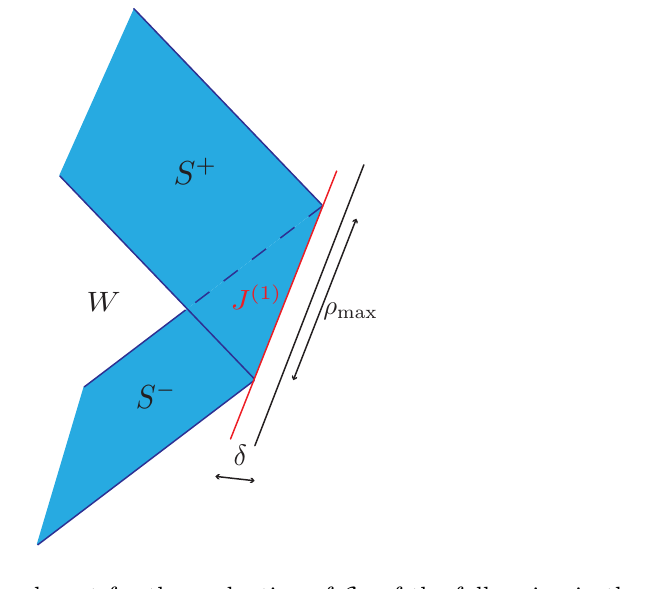
Figure 27 . The WDW patch relevant for the evaluation of C A of the full region in the poincar(cid:19)e patch of AdS d +1 . We introduce an IR regulator (cid:26) max in order to obtain a (cid:12)nite